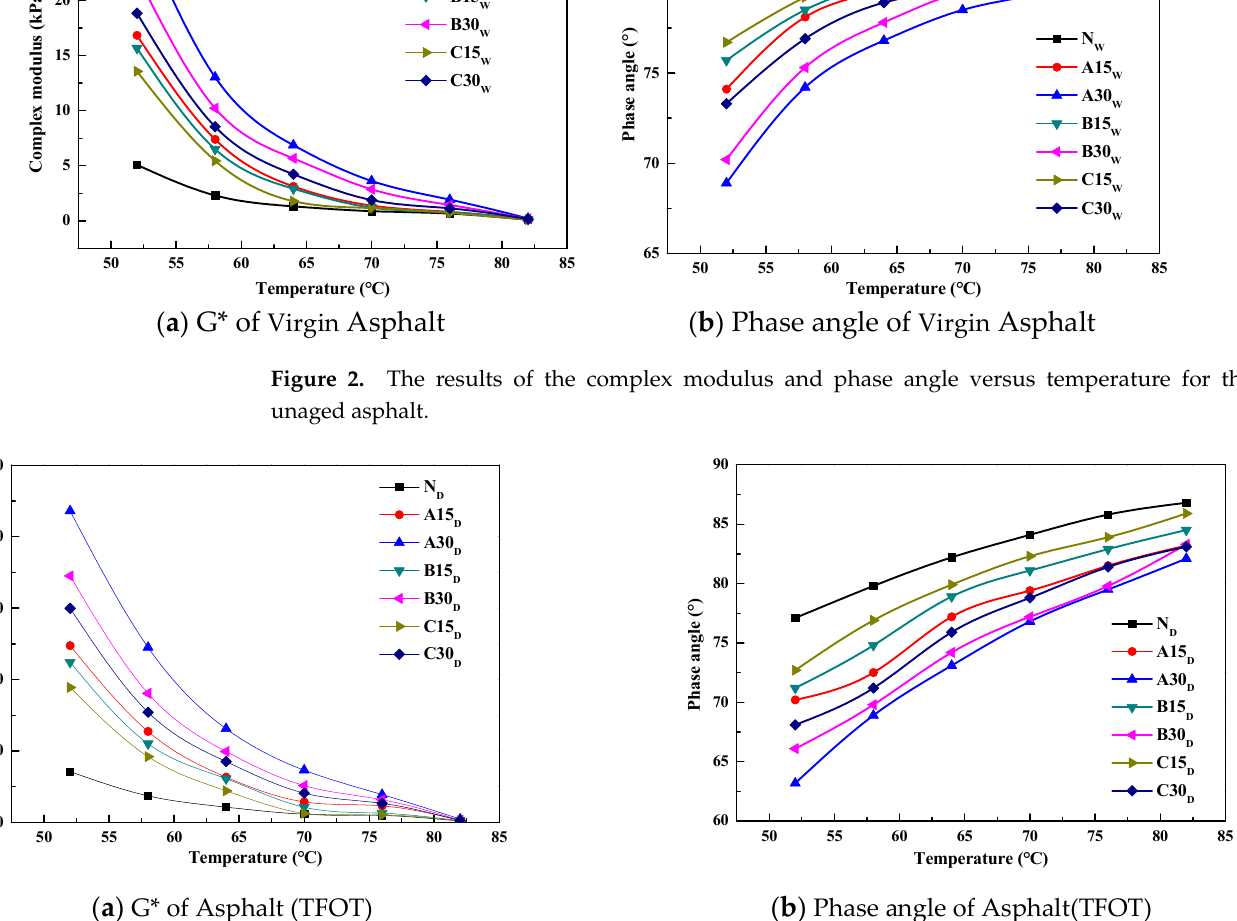
Figure 3. The results of the complex modulus and phase angle versus temperature for the short-term aged asphalt.